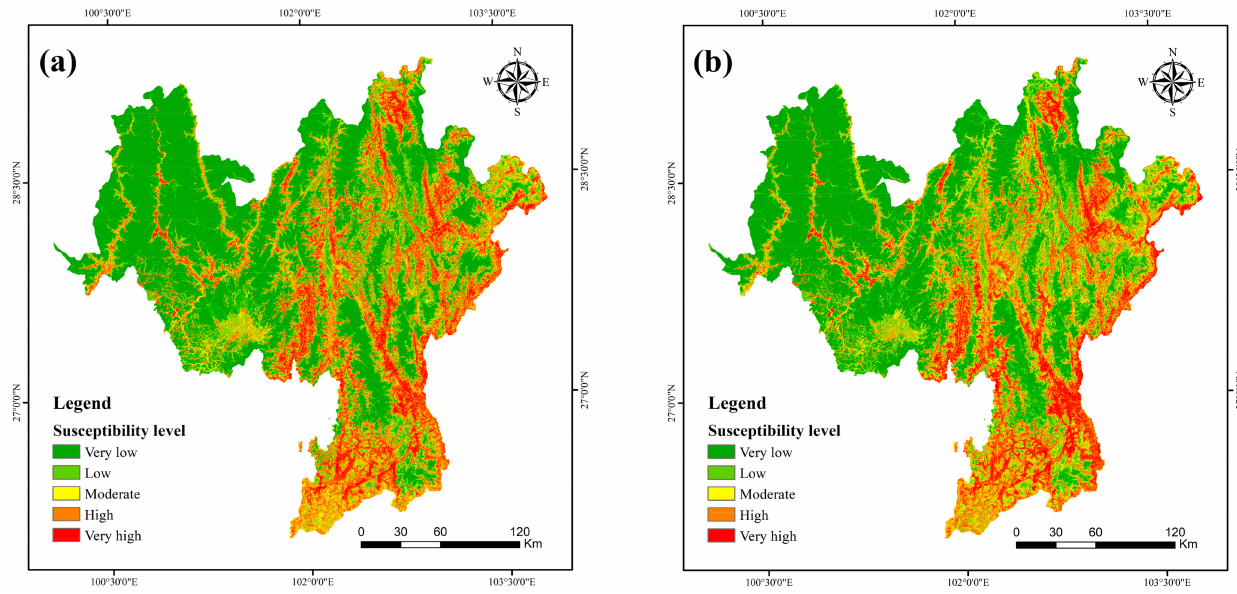
Figure 6. Landslide susceptibility maps: ( a ) RF; ( b )